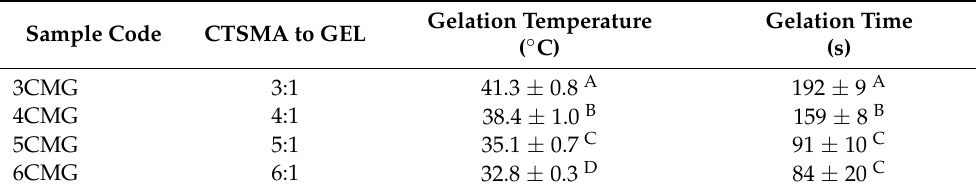
Figure 4. Dynamic temperature sweep analysis of various CMG hybrid hydrogels. Table 1. Gelation temperature and gelation time of CMG hybrid